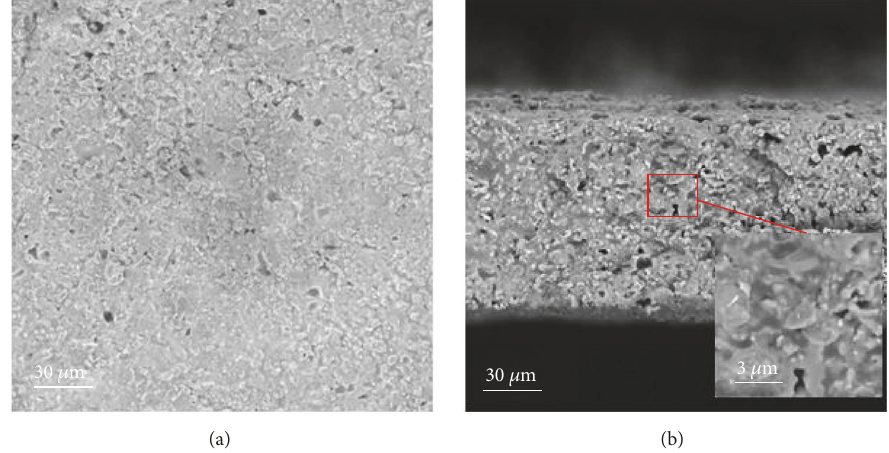
Figure 3: SEM images of printed substrate. (a) The upper surface. (b) The cross-sectional